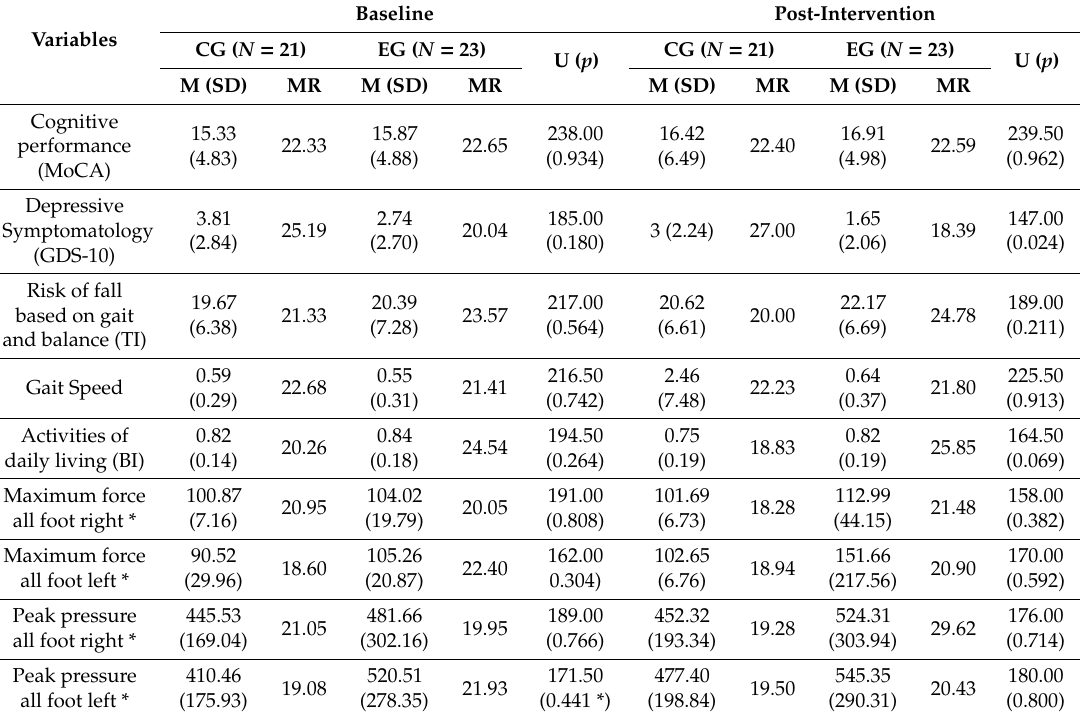
Table 2. Between group analysis—Mann Whitney